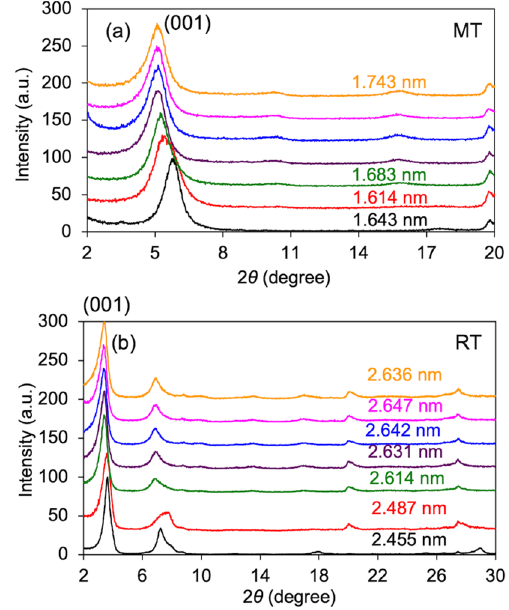
Figure 6. XRD patterns of MT ( a ) and RT ( b ) showing the expansion of (001) after sorption of AO. From bottom up, the initial AO concentrations were 0, 1, 2, 4, 6, 8, and 10 mM for MT and 0, 0.5, 1, 2, 3, 4, and 5 mM for RT. The values above each line denote the d 001